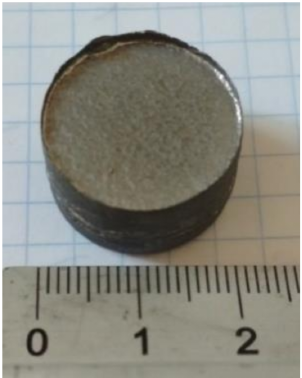
Figure 2. Photograph of spark plasma sintered zirconium sample with dimensions Ø20 × 30 mm.